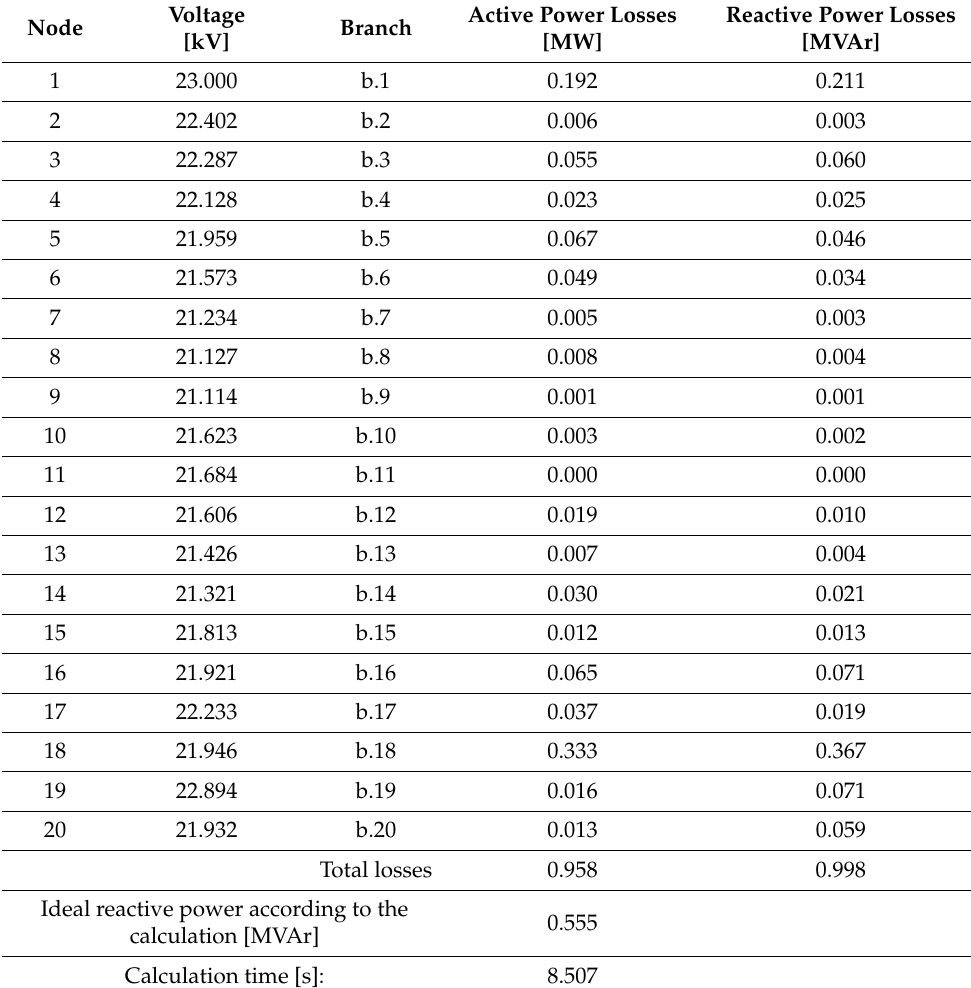
Table 6. Results of the steady-state solution using the SOMA algorithm after optimization calculation. Node